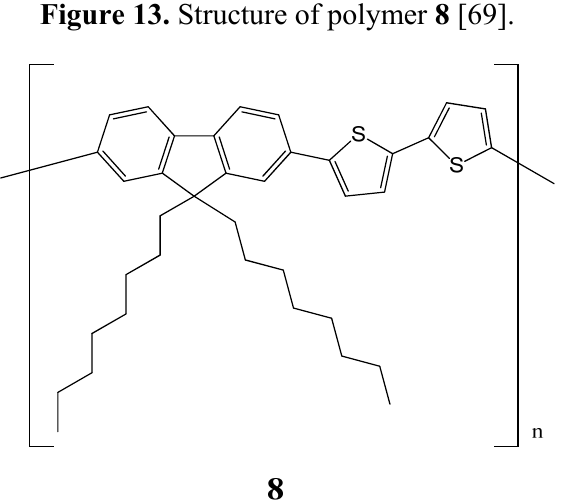
Figure 13. Structure of polymer 8